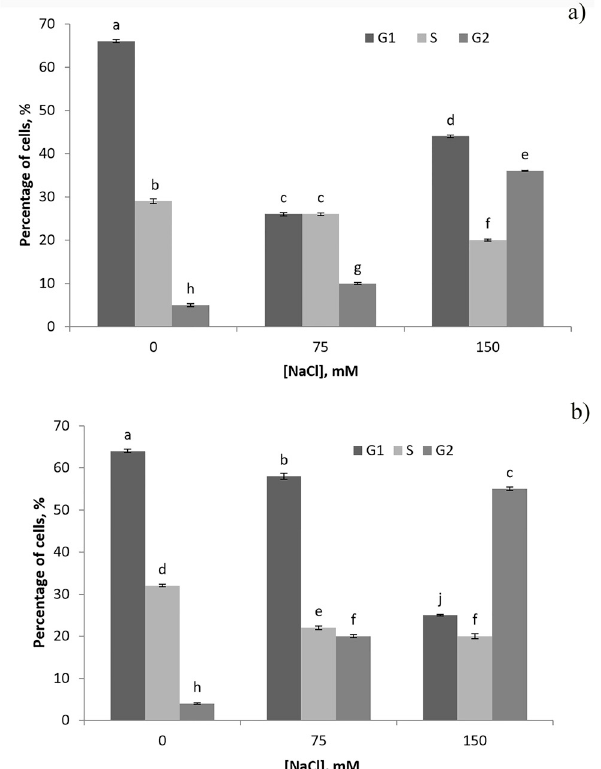
Figure 3. Determination of the distribution of the tomato root meristem cells of the YaLF line ( a ) and cv Recordsmen ( b ) by cytophotometric analysis in the phases of the cell cycle under various concentrations of NaCl. The columns indicate the percentage of cells in a given phase of the cell cycle. Means followed by the same letter are not significantly different at α = 0.05 according to Duncan’s multiple range test.